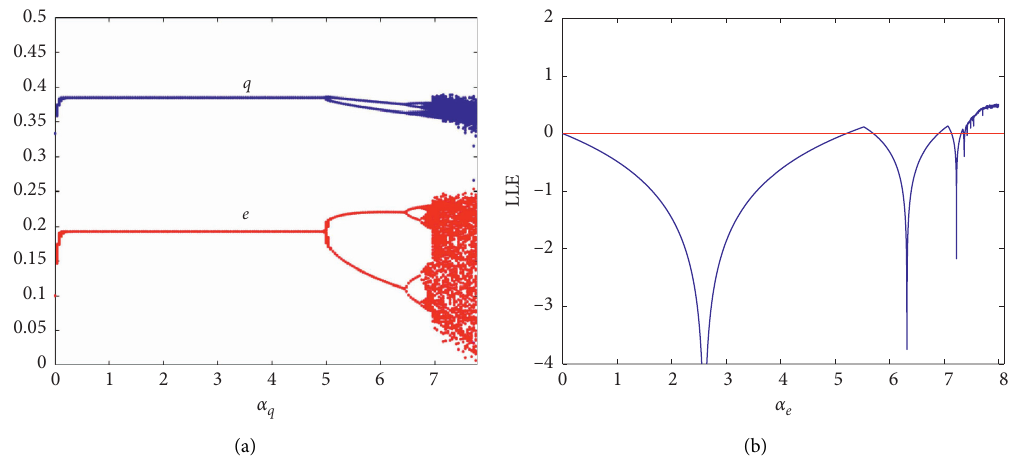
Figure 6: The bifurcation diagram of dynamic system (25) with respect to α